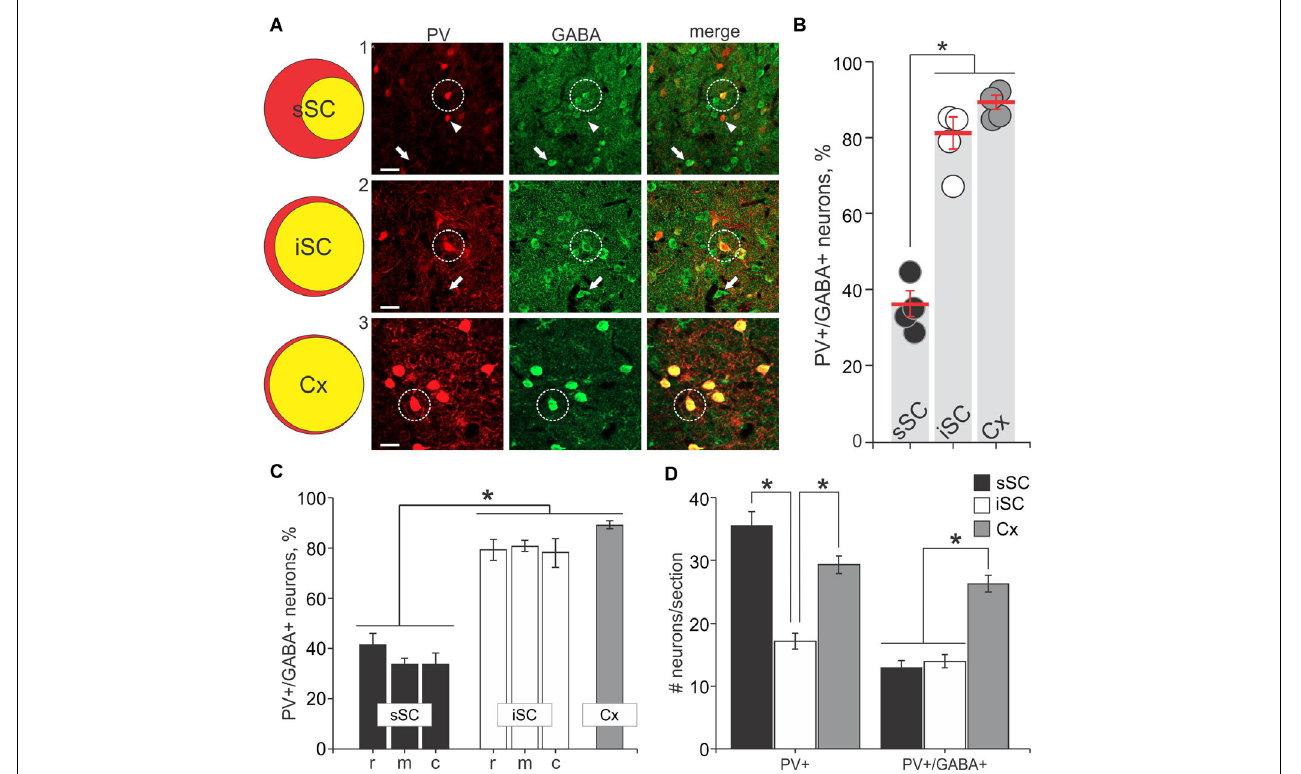
FIGURE 2 | PV + neurons contain GABA + in the SC. (A) Far left, Venn diagrams representing the proportion of PV + /GABA + neurons (yellow) of the total number of PV + neurons (red) from sections of sSC, iSC and V1 of cerebral cortex (Cx). Right panels, confocal images of sections from sSC, iSC, and Cx (row A 1 − 3 , respectively) showing PV + (left column), GABA + (middle), and the merged images (right). White arrowheads indicate examples of PV + neurons. White arrows show examples of GABA + neurons and white circles highlight PV + /GABA + neurons. Scale bar: 20 µ m. (B) Percentage of PV + /GABA + neurons of the total number PV + neurons counted in sSC, iSC, and Cx for each of the mice ( n = 4). Red line, mean ± SE. (C) Mean percentage of double-labeled PV + /GABA + neurons in sections from sSC (black), iSC (white) obtained from rostral (r), middle (m) or caudal (c) SC brain slices and from Cx (gray). ∗ p < 0.05, Kruskal–Wallis. Bar: mean ± SE. (D) Mean ± SE number of PV + and double labeled PV + /GABA + neurons per section (4–8 sections/mouse) from sSC, iSC, and Cx. ∗ p < 0.05,